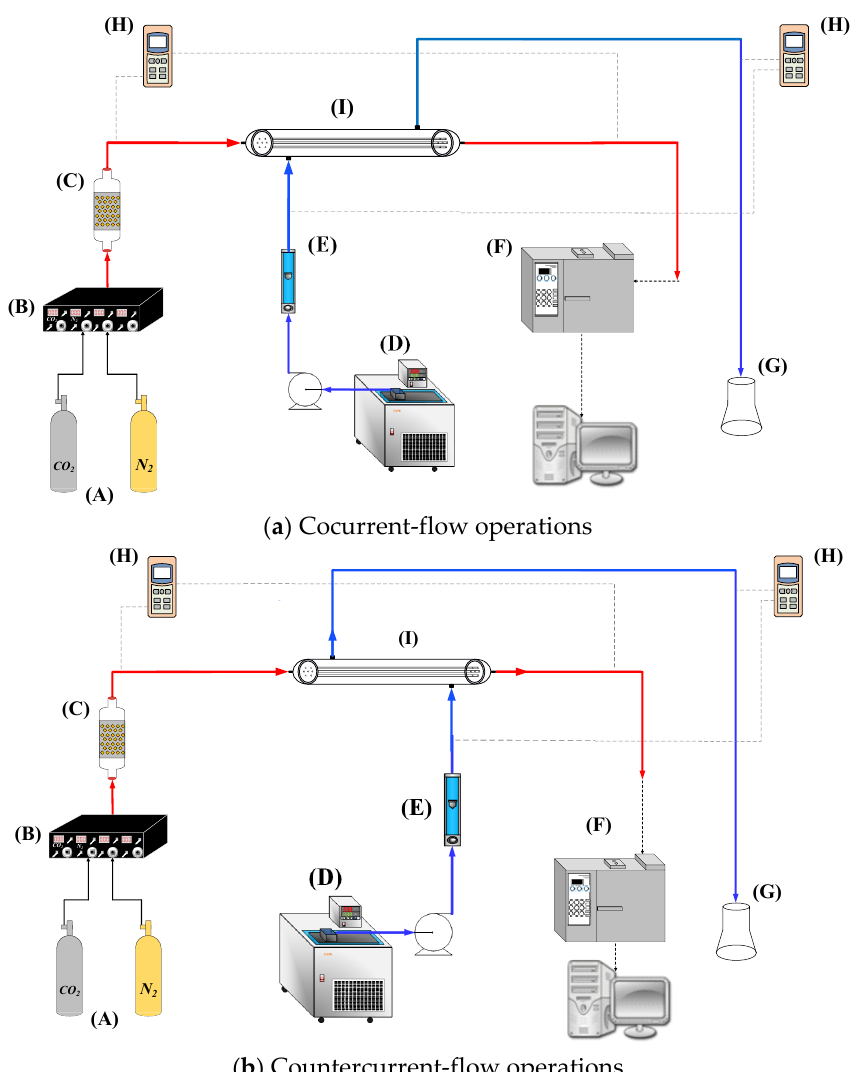
Figure 7. Experimental setup for hollow-fiber gas/liquid membrane contactors: (A) gas cylinder; (B) mass flow controller; (C) gas mixing tank; (D) thermostatic tank; (E) flow meter; (F) chromatog- raphy; (G) Erlenmeyer flask; (H) temperature indicator; and (I) ceramic hollow-fiber module.